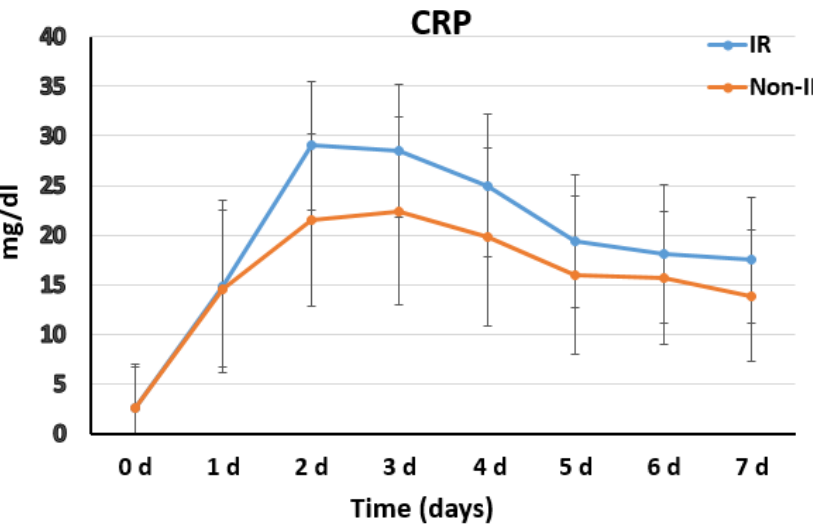
Figure 5. Postoperative distribution and trends of the C-reactive protein (CRP) values in the IR and non-IR group.